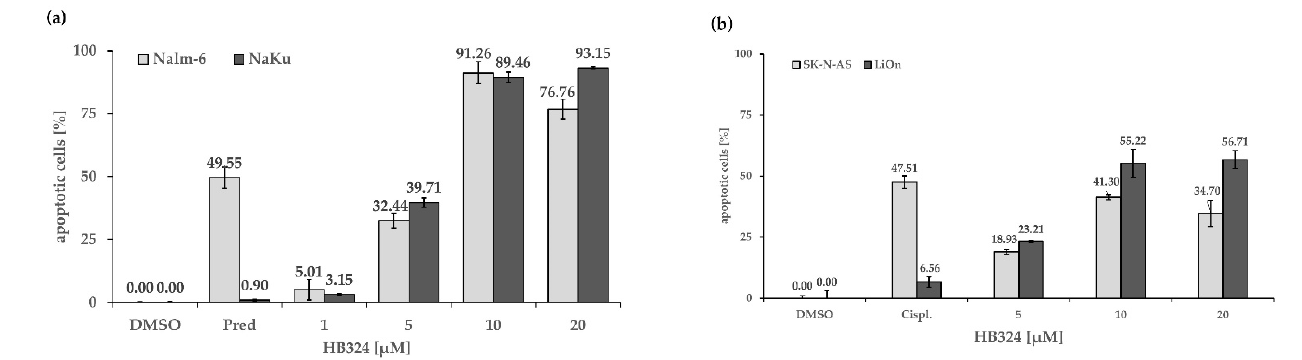
Figure 5. ( a ) Apoptosis induction by HB324 in Nalm-6 and prednisolone-resistant Nalm-6 cells (NaKu). After 72 h of incubation with different concentrations of the agent DNA fragmentation was measured via FACS scan analysis. Solvent treated cells (0.5% DMSO) served as the control, and 55.6 µM prednisolone (Pred) served as the positive control. Values of DNA fragmentation are given as mean percentages of cells with hypodiploid DNA ± SD (n = 3). ( b ) SK-N-AS and LiOn cells were treated with 5 µM, 10 µM, and 20 µM of HB324. Solvent treated cells (0.5% DMSO) served as the control, and 7.5 µM cisplatin (Cispl.) was pipetted in both cell lines to prove the resistance. After 72 h of incubation, DNA fragmentation was measured by flow cytometric analysis. Values are given as % of cells with hypodiploid DNA as mean values ± SD (n = 3).